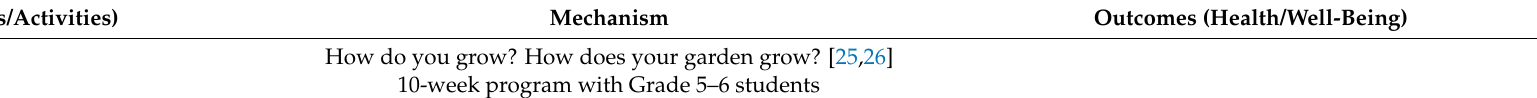
Table 1. Context–Mechanism–Outcome configuration of individual school gardening